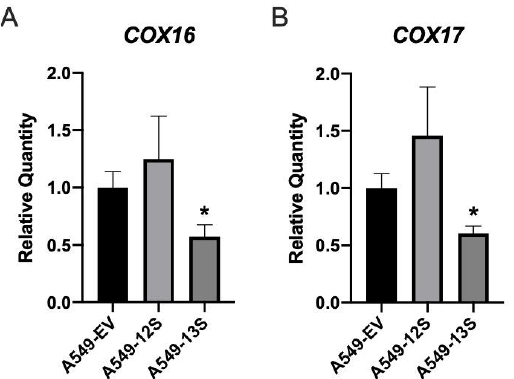
Figure 5. Relative expression of mRNA for cellular respiration genes in 13S and 12S expressing A549 cells. The mRNA expression for two genes encoding components of the TCA cycle were measured with qPCR. A549-13S cells exhibit downregulated expression of genes encoding components of cellular respiration complex IV. Both ( A ) COX16 and ( B ) COX17 mRNA expression was significantly lower in A549-13S cells compared to A549-EV cells. A549-12S cells did not show statistically significant expression differences when compared to A549-12S cells. The geometric mean of two reference genes, H2AFY and ACTB was used. Asterisks (*) indicate p < 0.05. n = three per group for all panels. COX16 ; Cytochrome C oxidase assembly factor COX16; COX17 , Cytochrome C oxidase copper chaperone COX17.